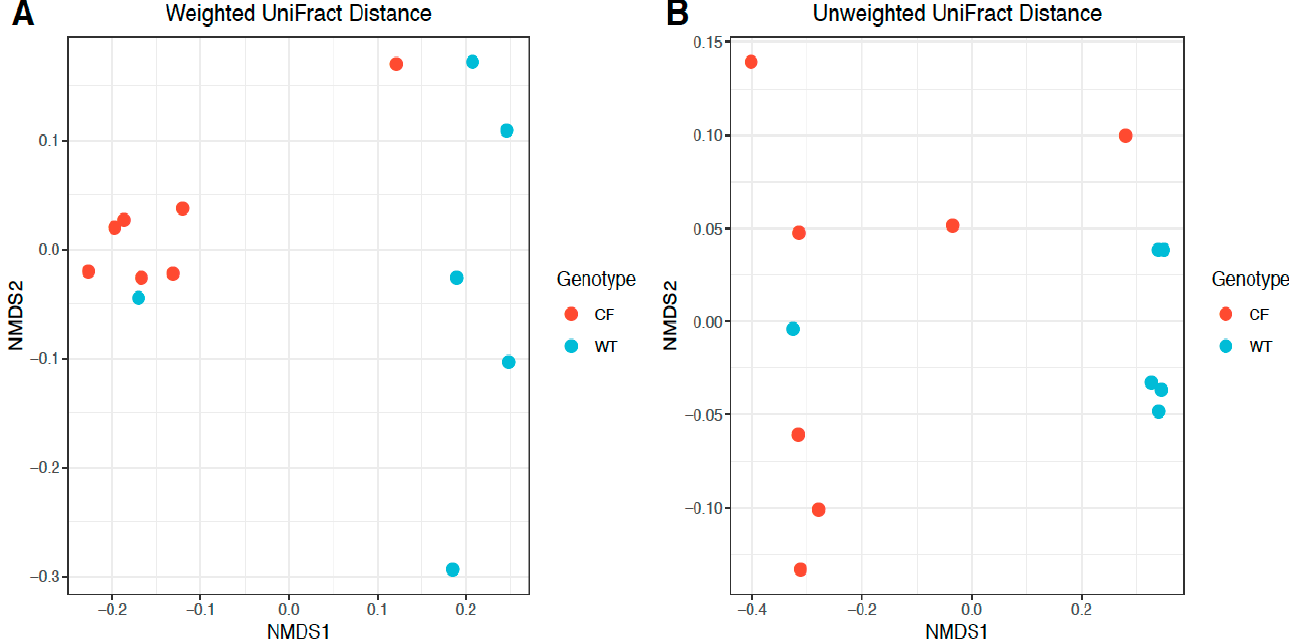
Figure 4. Beta diversity comparison between CF and WT groups based on OTU abundance. Beta diversity was calculated by phylogeny-based ( A ) weighted and ( B ) unweighted UniFrac distances based on relative abundances of identified OTUs, and visualized by non-metric multidimensional scaling (NMDS).